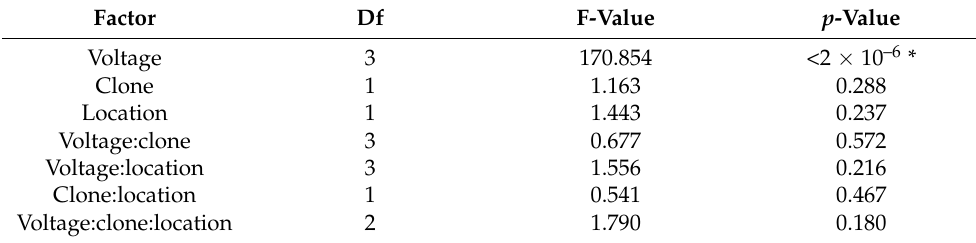
Table 7. Rootwave experiment. Results of the three-way ANOVA test performed in order to evaluate the main and interaction effects of the factors voltage (V), clone, and location on C. esculentus shoot